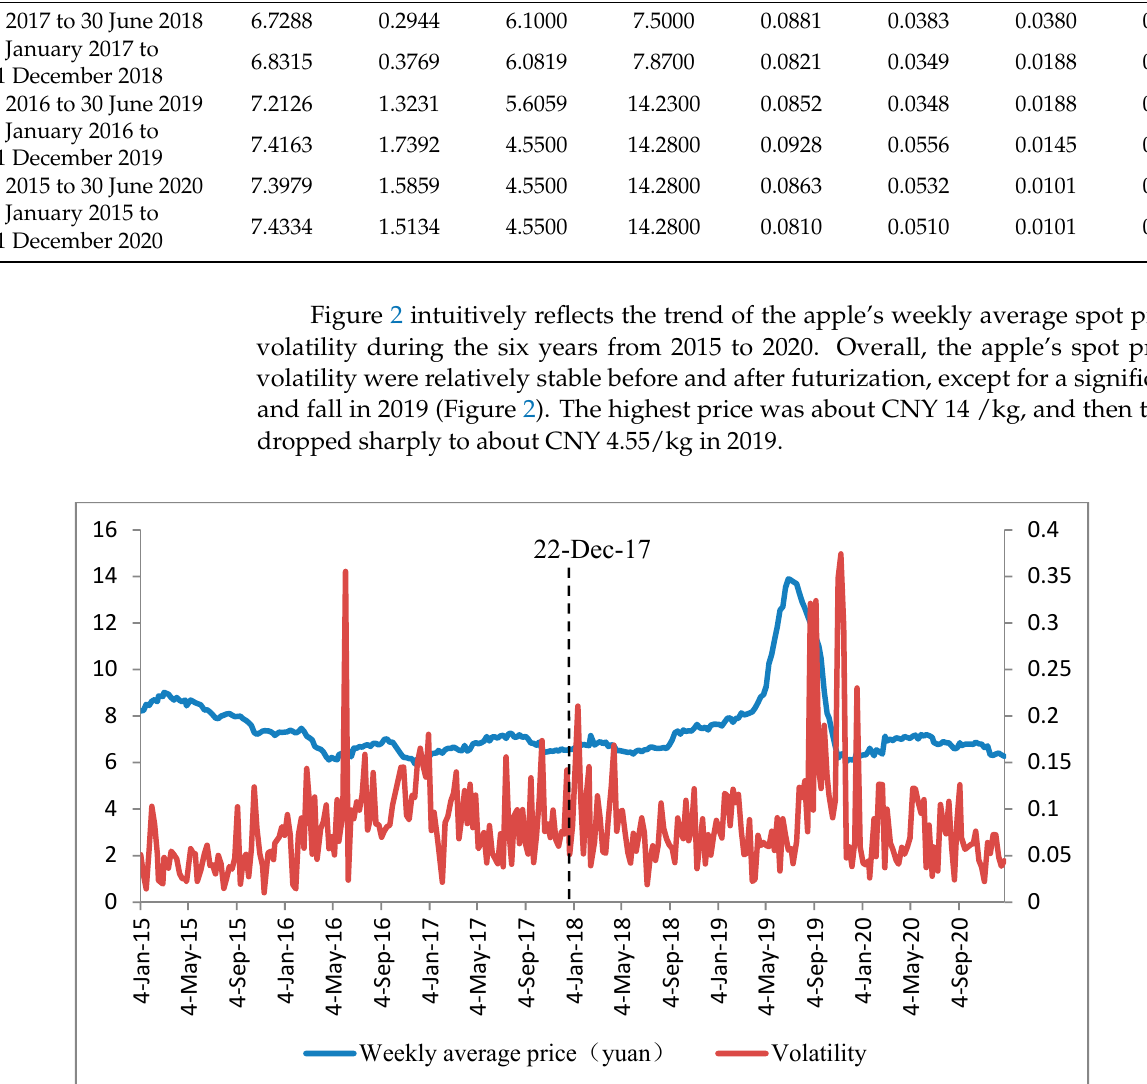
Figure 2. Apple spot price and volatility trends.